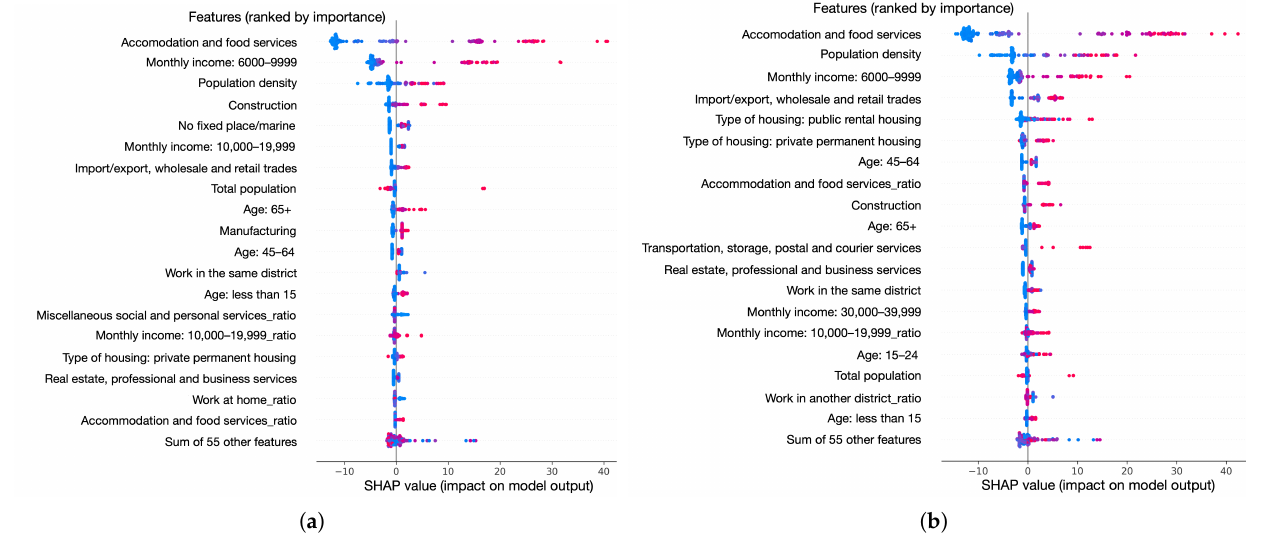
Figure 5. The overview of the features’ SHAP values. The features are ranked by importance (the most important is at the top). Red color means higher feature values and blue means lower feature values. Lower SHAP values mean lower COVID-19 cases. ( a ) Top 20 most important features and the sum of 55 other features for the prediction of local cases. ( b ) Top 20 most important features and the sum of 55 other features for the prediction of all